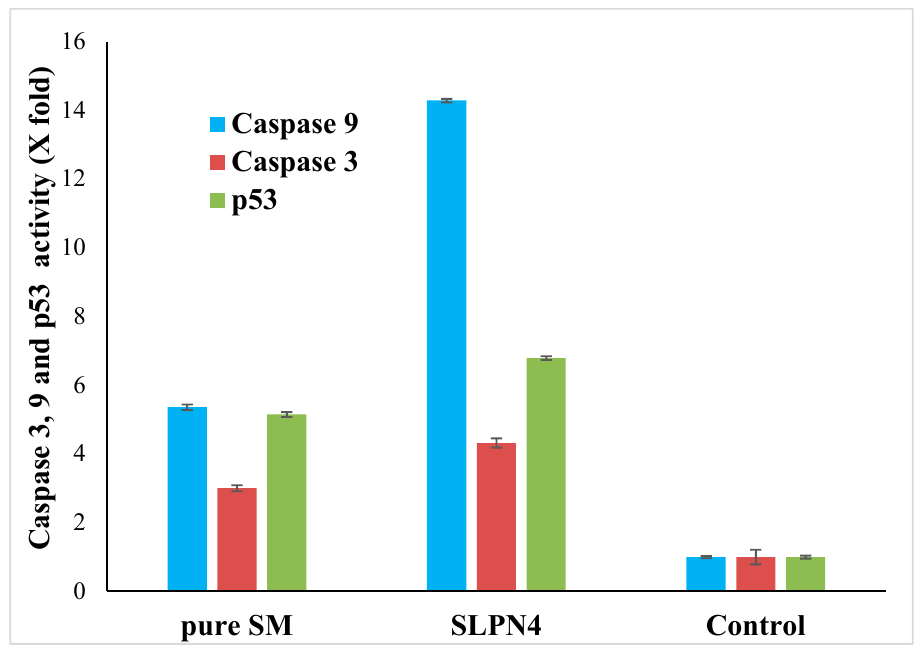
Figure 10. Activation of caspase 3, 9, and p53 in pure SM- and SLPN4-treated MCF7 cells was compared to the untreated control. SLPN4 ( p < 0.05) vs. free SM and control group.